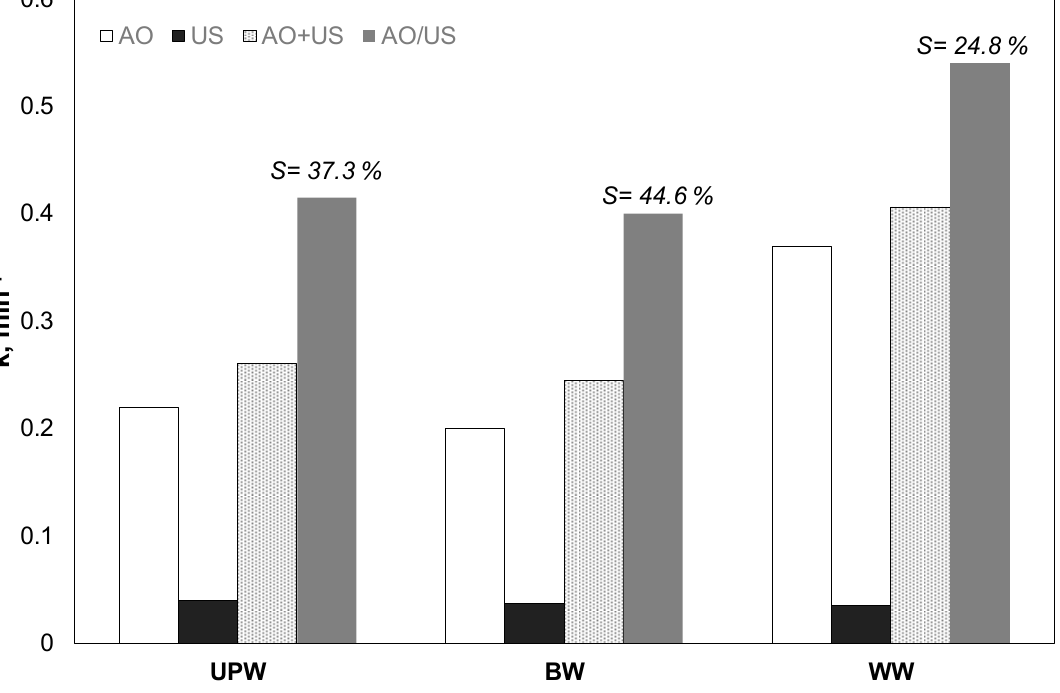
Figure 7. (Apparent) kinetic constant for the removal of 0.5 mg/L propyl paraben by electrochemical anodic oxidation (AO), ultrasound (US), theoretical sum (AO + US) and combined (AO/US) process in different water matrices [Na 2 SO 4 ] = 0.1 M, 3.75 mA/cm 2 , 36 W/L at 20 kHz and inherent pH.